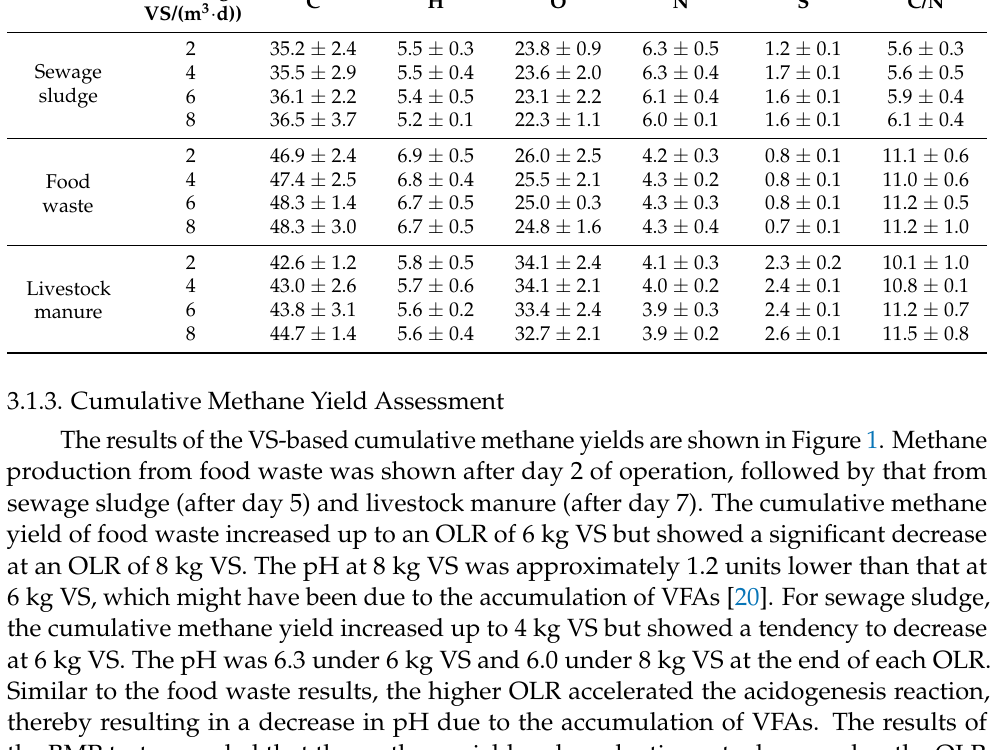
Table 3. Chemical composition of organic waste.